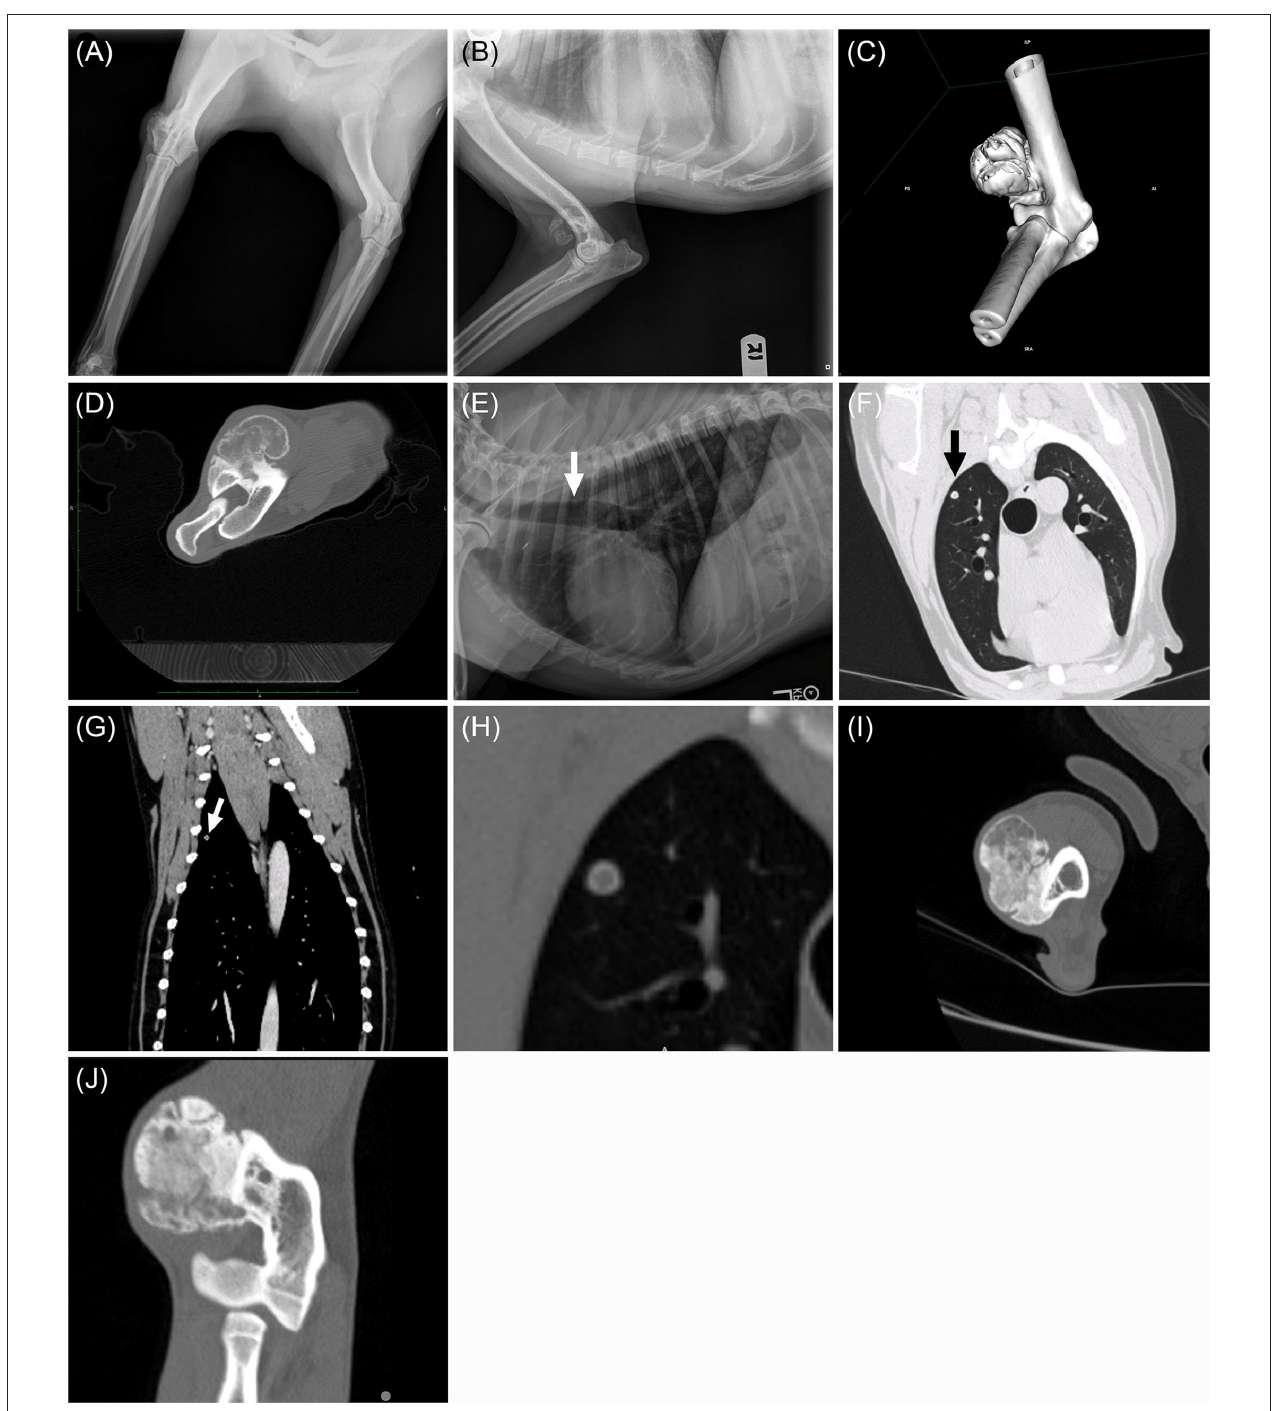
FIGURE 1 | Craniocaudal (A) and mediolateral (B) radiographs of the right elbow. Note the smoothly marginated bony proliferation arising from the craniodistolateral humerus. Post-contrast transverse computed tomographic image of the right distal humerus. (C) Three-dimensional reformatted CT imaged displayed in a bone window and (D) lateromedial post-contrast transverse computed tomographic image of the right distal humerus. Note the lobular mineral proliferation arising from the craniodistolateral humeral metaphyseal cortex and lack of underlying humeral bone lysis. Left lateral thoracic radiograph (E) : 5mm rounded nodule within the dorsal third intercostal space (white arrow). Transverse lung window (F) and dorsal reformatted bone window (G) CT showing the pulmonary nodule within the right cranial lung lobe (black and white arrows). The thin, mineralized rim with a soft tissue center is evident on the enlarged transverse CT image displayed in a bone window (H) . Transverse (I) and dorsal (J) plane CT images in a bone window of the right elbow from repeat CT scan 217 days after completion of SBRT. Note that the soft tissue portions of the mass are more mineralized and the humeral cortex remains intact.